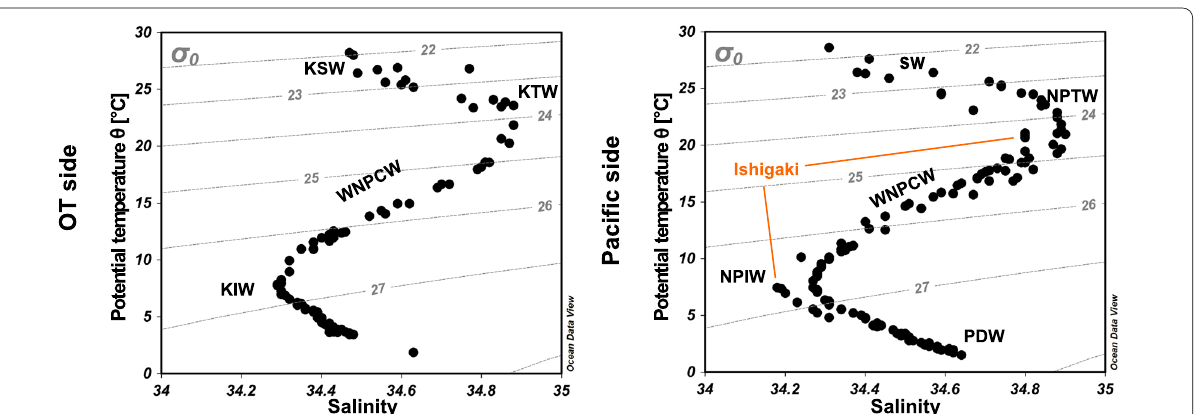
Fig. 4 Potential temperature–salinity plots for the Okinawa Trough (left panel) and Pacific (right panel) sides of the southern Ryukyu Island Arc. Data from the Japan Oceanographic Data Center